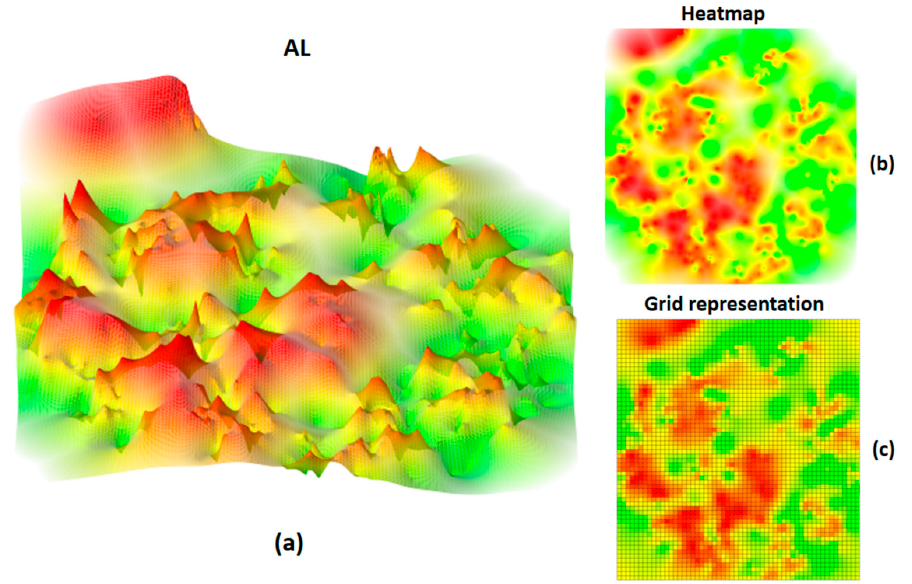
Figure 2. Activity landscape and heatmap representations. In ( a ), the 3D AL of a set of corticotropin-releasing factor receptor 1 ligands taken from ChEMBL version 23 [21] is shown (generated as detailed in the Methods Section). The surface is color-coded according to compound potency using a continuous spectrum ranking from red (high potency) over yellow to green (low potency). In ( b ), the corresponding heatmap is displayed. In ( c ), the heatmap is represented on an evenly spaced grid. In Figure 3 below, the heatmap of the of corticotropin-releasing factor receptor 1 ligands is enlarged, and positions of exemplary weakly or highly potent compounds are mapped. These compounds originated from two different analog series and occupy distant regions in the heatmap. The weakly potent compounds are found in a green region (corresponding to a valley) and the highly potent in a red region (formed by peaks). The representation illustrates color intensity-based encoding of 3D AL topology resulting from different compound potency levels. For heatmaps, red and green channel pixel intensity values were combined into a single intensity value ranging from -1 to 1 (see Methods). To identify peaks using color intensities, positive threshold value intervals of (0, 0.25), (0.25, 0.5), (0.5, 0.75), and (0.75, 1.0) were applied. To identify smooth regions (valleys), negative threshold intervals of (0, − 0.25), ( − 0.25, − 0.5), ( − 0.50, − 0.75), and ( − 0.75, − 1.0) were used. Thus, different threshold intervals represented highest elevations (peaks), deepest valleys, and intermediate peak-to-valley and valley-to-peak regions. It should be noted that pixel intensities do not only encode potencies of individual molecules. Because intensities are obtained by interpolating a color gradient reflecting potencies of neighboring compounds, pixel intensities also implicitly account for locality information.